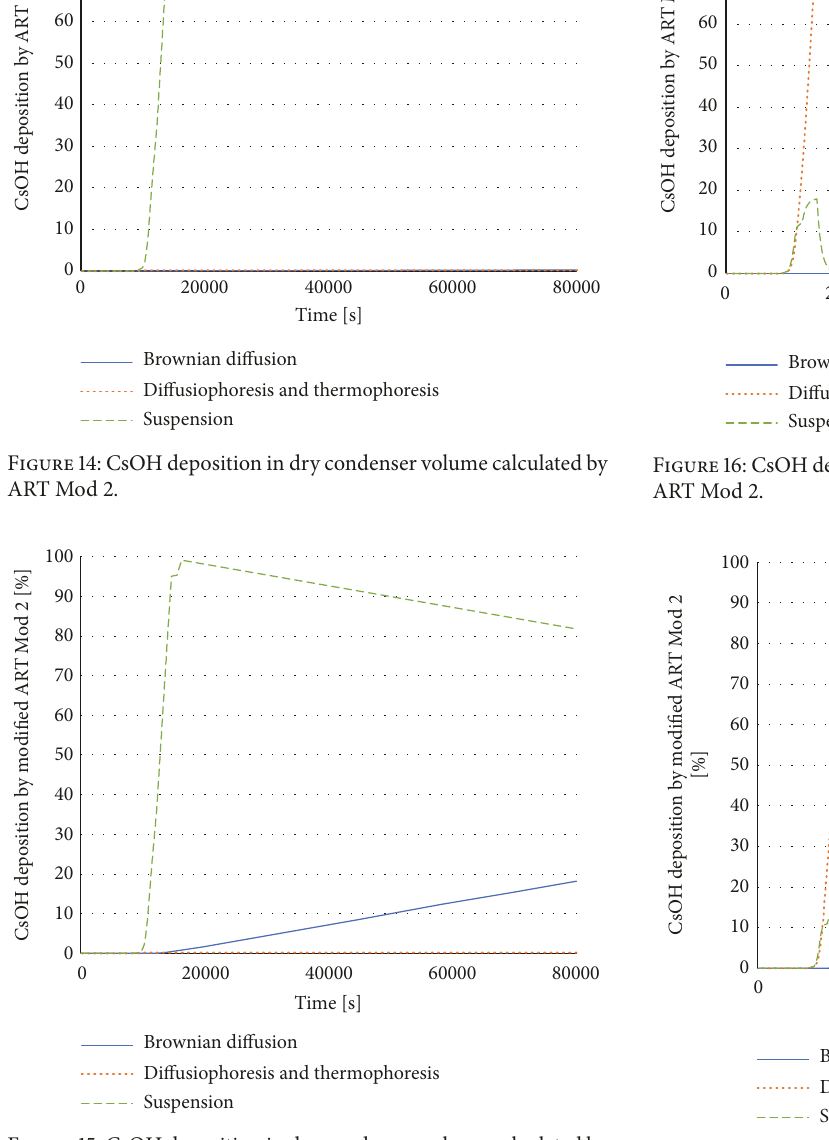
Figure 17: CsOH deposition in wet condenser volume calculated by modified ART Mod